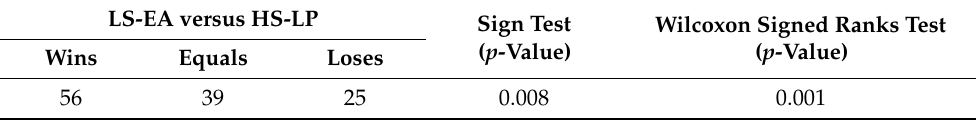
Table 6. Statistical comparison of LS-EA and